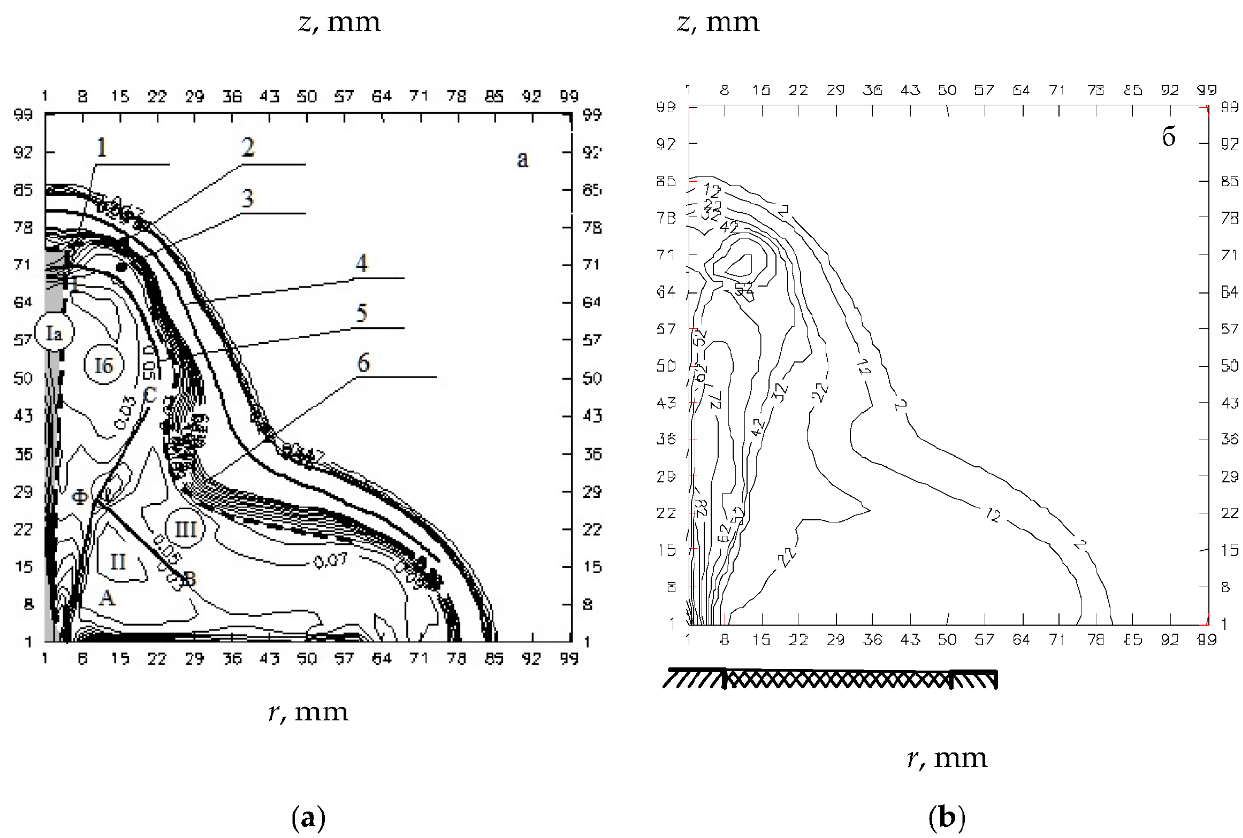
Figure 2. Lines of the density ρ (kg/m 3 ) ( a ), temperature T (kK) ( b ) at the time t = 15.3 μs at a discharge current J = 281 kA for an MPC with parameters C = 750 μF, U 0 = 5 kV in argon with pressure p = 10 − 2 MPa ( A m = 0.6). The electrode assembly: 1: contact boundary (CB), 2: shock-compressed gas (SCG), 3: shock-compressed plasma (SCP), 4: a shock wave in a gas (GSW), 5: a shock wave in plasma (PSW), 6: contact boundary separating the regions of the surrounding gas SCG and light erosion plasma SCP.